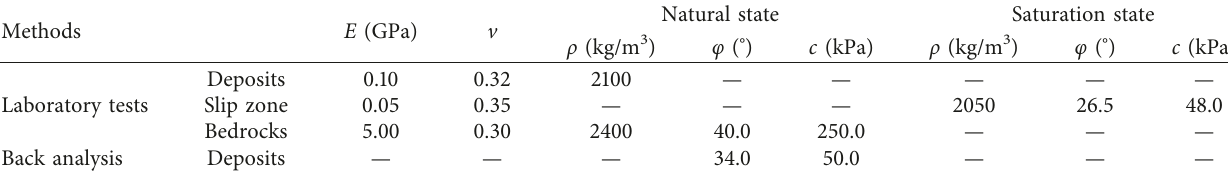
Table 1: Recommended shear parameters of three layers for Zhenggang landslide.